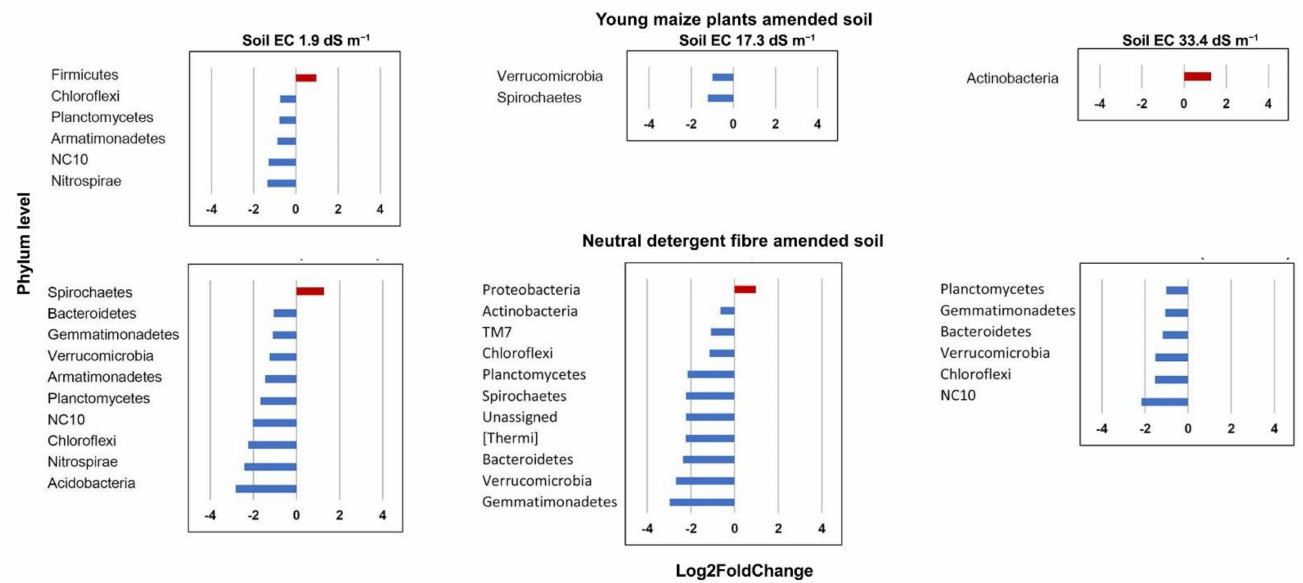
Figure 5. Differential abundance analysis with DESEq2 package [42]. A positive Log2FoldChange value (red bar) indicates a phylum that was significantly enriched by the application of young maize plants or its neutral detergent fibre (NDF) fraction, whereas a negative one (blue bar) indicates that the relative abundance of the phylum was significantly higher in unamended control soil. Only significantly affected bacterial groups at the taxonomic level of phylum are shown based on the Wald’s test ( p <